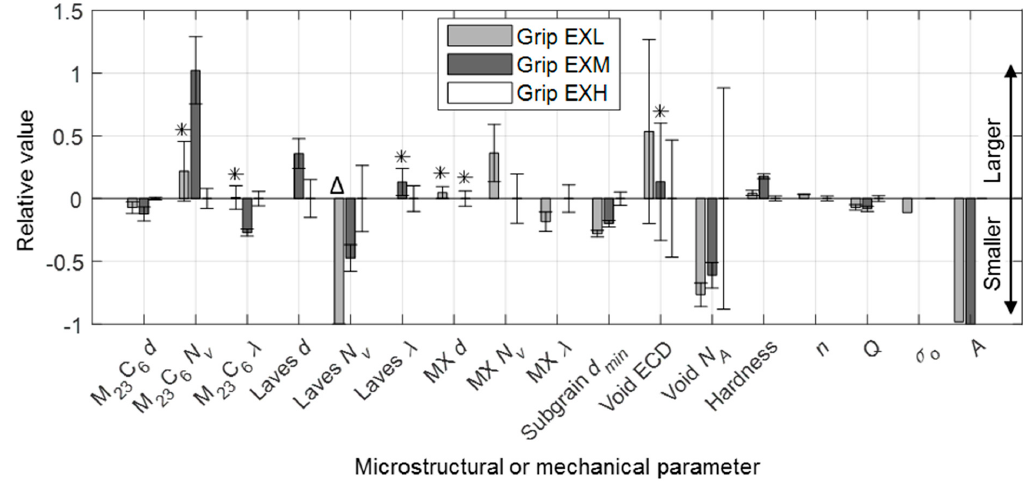
Figure 22. Relative di ff erences in microstructural parameters indicating damage using the EXH grip region as a baseline. Note: d = diameter, d min = minor diameter, N v = volume density, λ = inter-particle spacing, N A = area density, n = stress exponent, Q = activation energy, σ o = threshold stress, A = Zener–Hollomon pre-exponential. Asterisks (*) indicate features that are not statistically di ff erent from the baseline. ∆ indicates that no Laves phase was recorded in the EXL grip